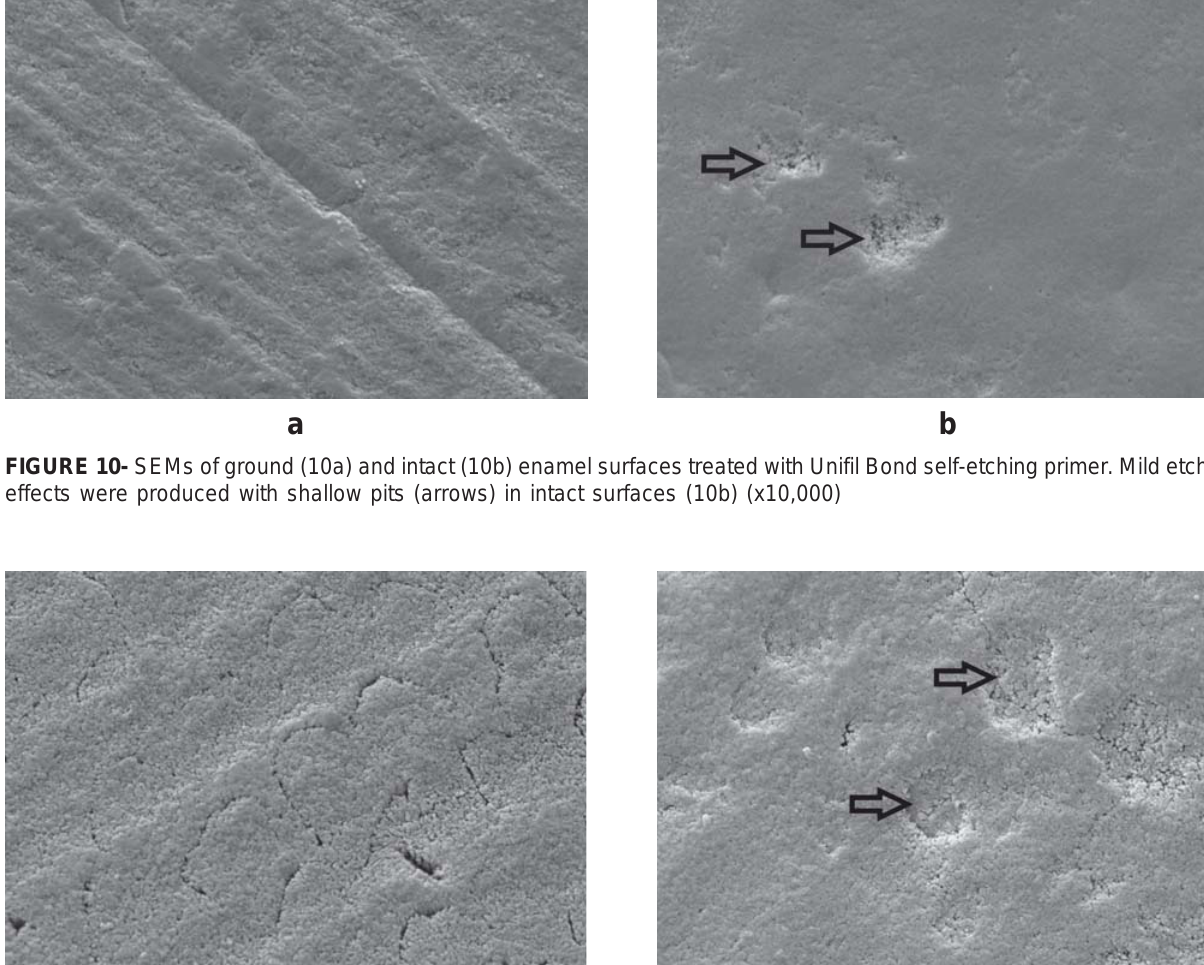
a FIGURE 11- SEMs of ground (11a) and intact (11b) enamel surfaces treated with Xeno III self-etching adhesive. Enamel crystallites and interprismatic areas were observed after Xeno III application on ground surfaces (11a) and shallow pits (arrows) were noted along the intact surfaces (11b) (x10,000)